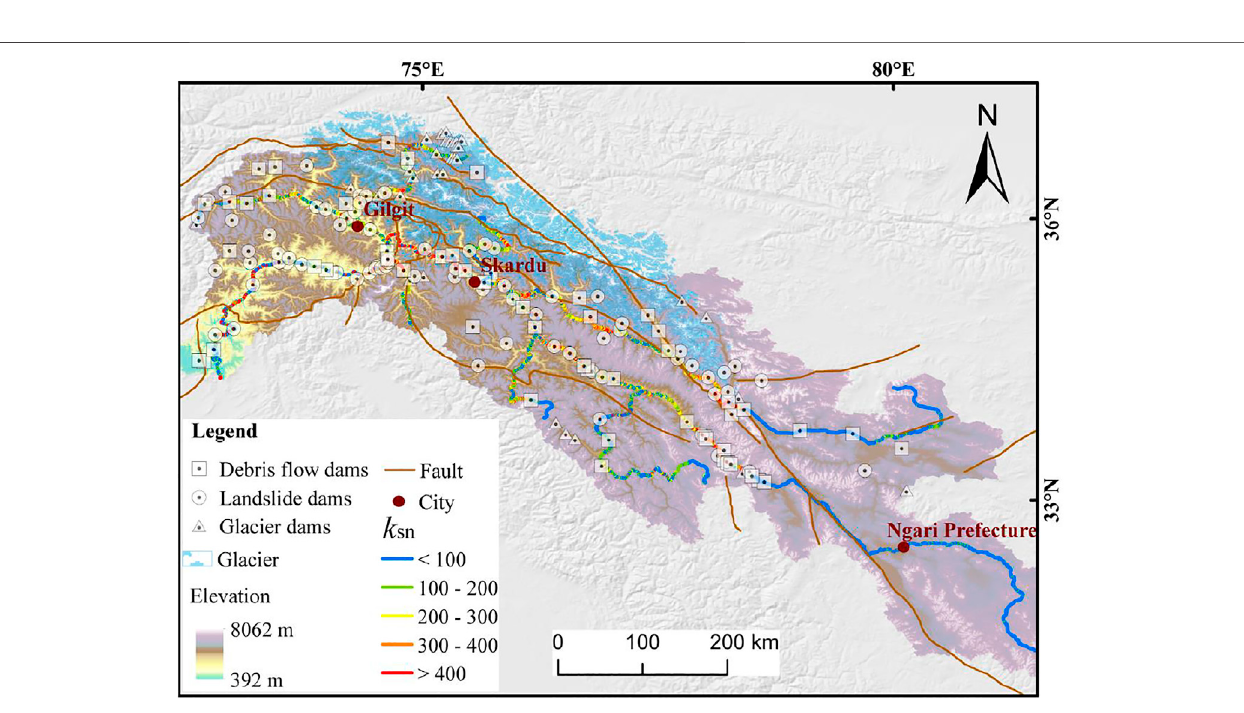
Frontiers in Earth Science |